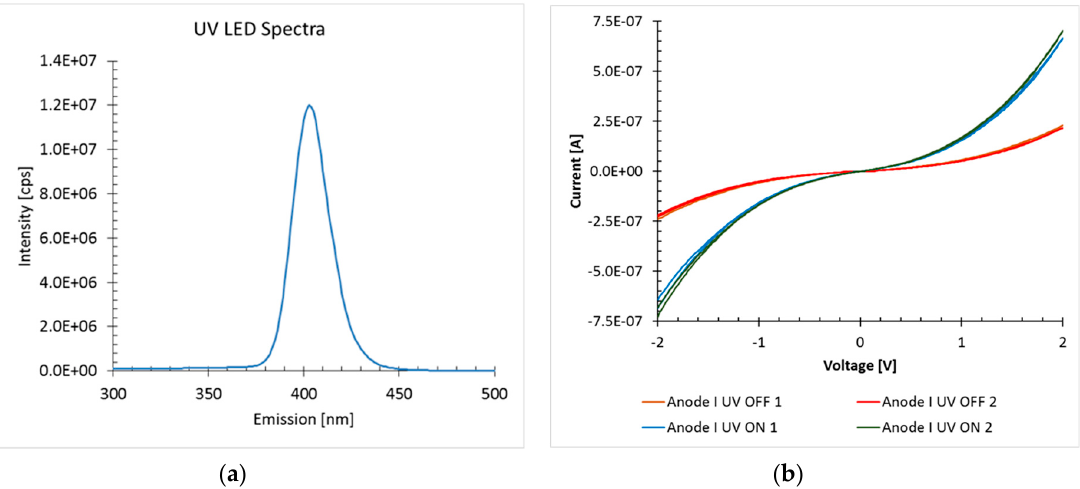
Figure 4. First UV sensing results with infiltrated ZnO. ( a ) Spectral range of the UV LED used. ( b ) Current vs. voltage (I-V) curve with the UV Light-Emitting Diode (LED) turned off and on (dark line going from − 650 nA to +650 nA at ± 2V).